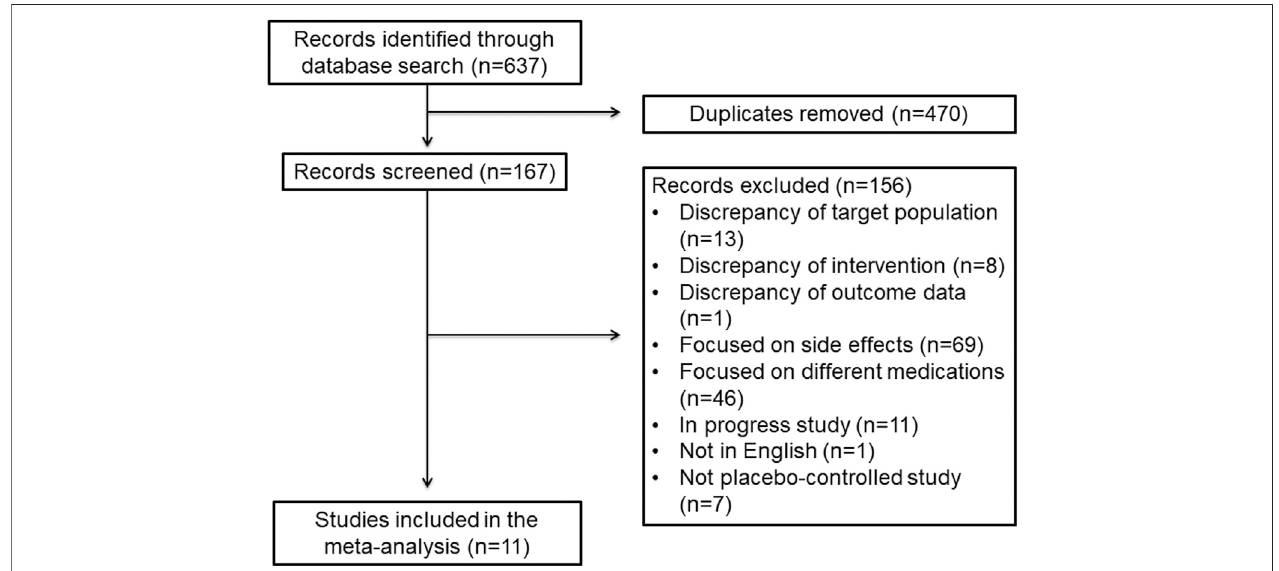
FIGURE 1 | Flow diagram of this systemic review and